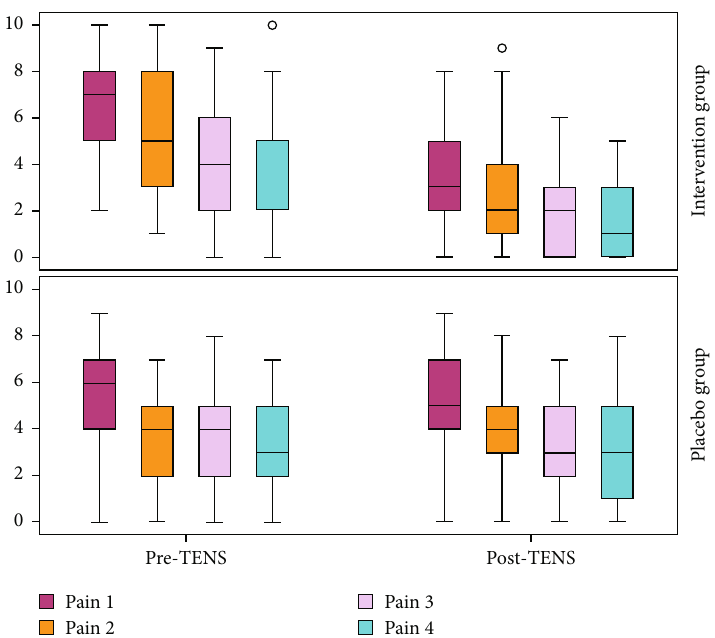
Figure 2: Comparisons between pain scale evaluations (VAS) before (pre-TENS) and after (post-TENS) 4 electroanalgesia sessions in the intervention group and in the placebo group ( p < 0 : 001